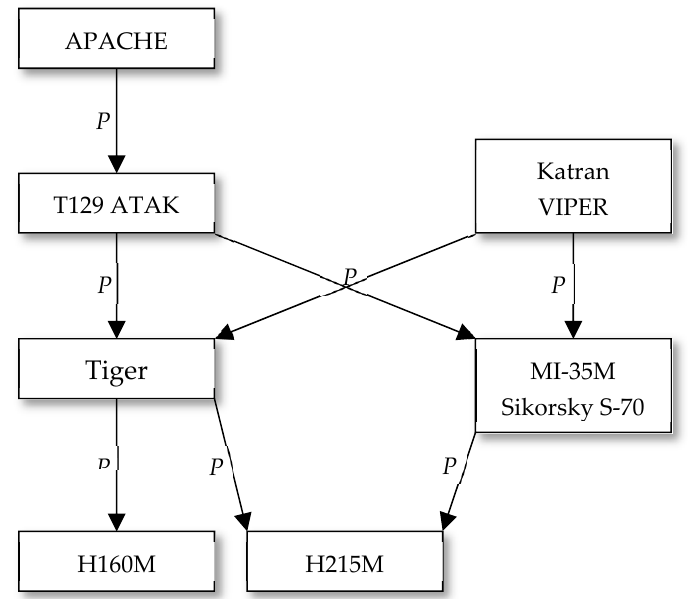
Figure 6. Graph or preference between the alternatives based in the outranking. Table 15. Intra-criterion analysis regarding the criterion Troop capacity.